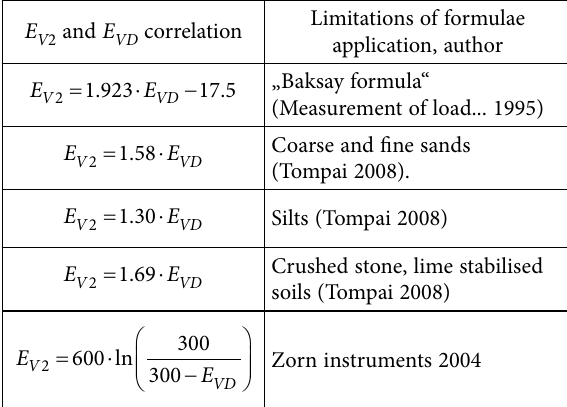
and E correlations. V 2 VD